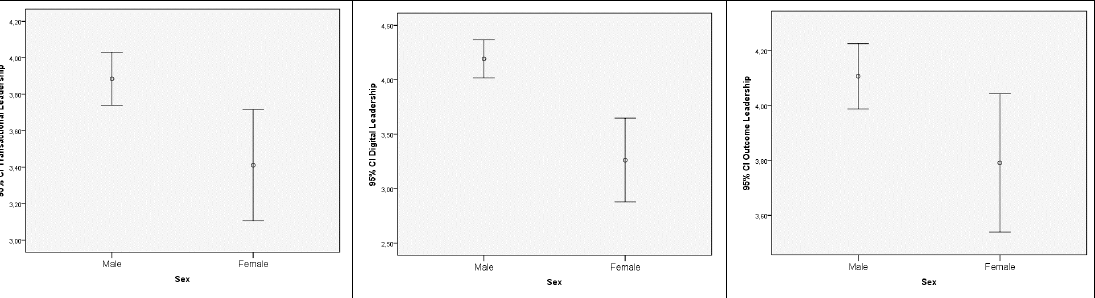
Figure 6. Leadership Types per